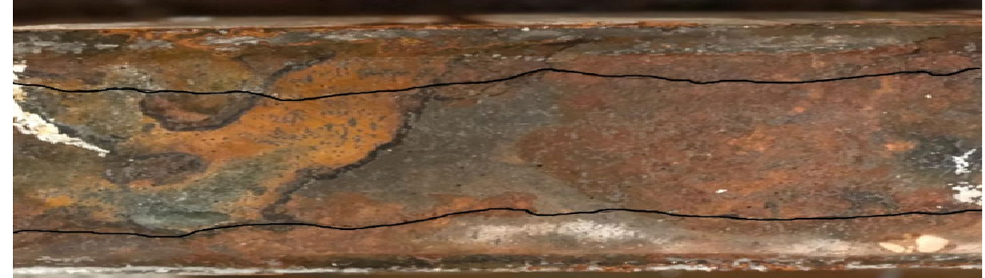
Figure 9. Cracks and rust stains on the bottom surface of a corroded RC